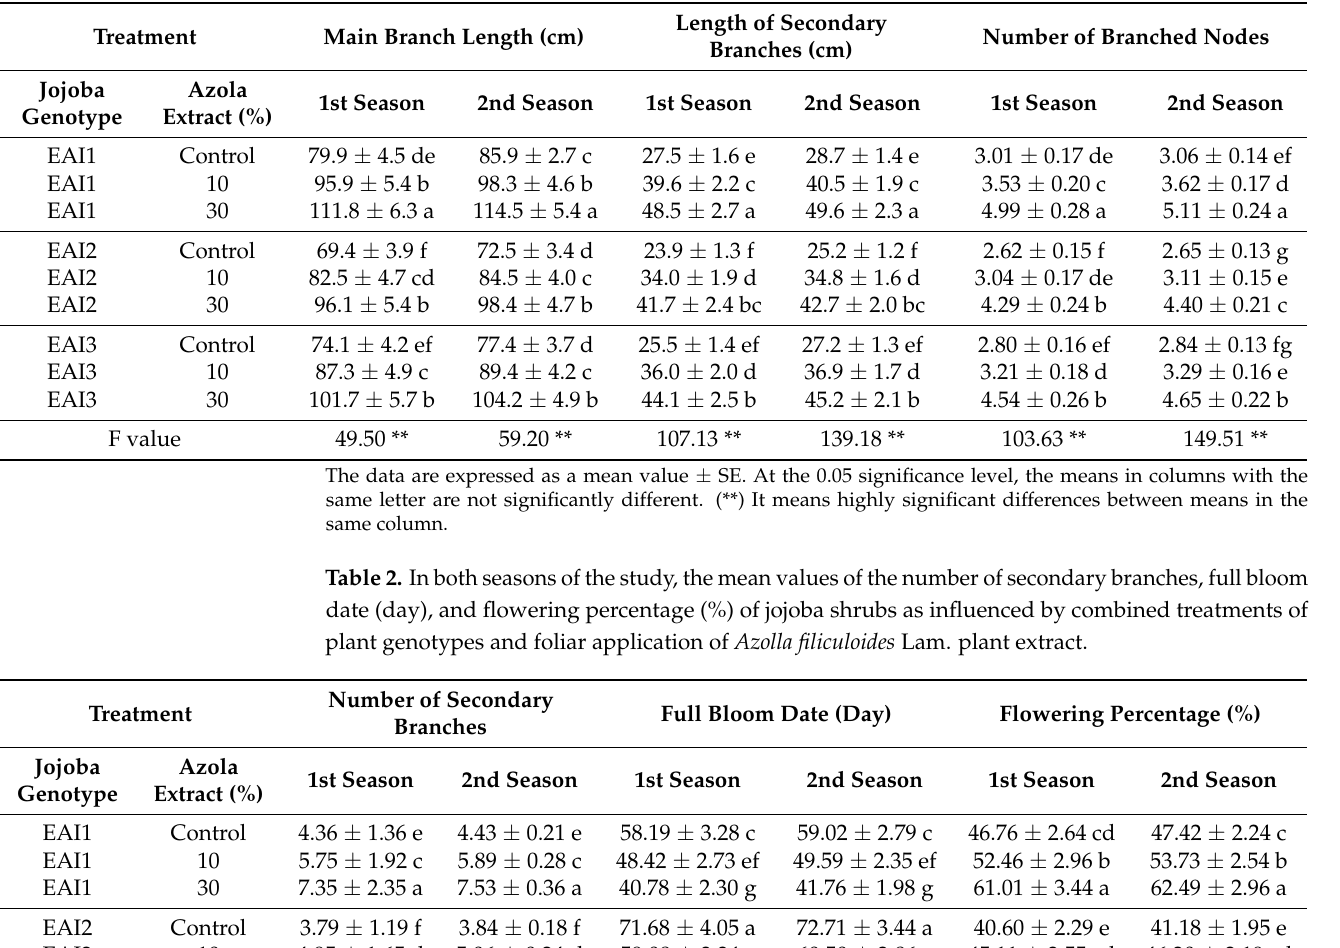
Table 1. In both seasons of the study, the mean values of main branch length (cm), secondary branch length (cm), and the number of branched nodes of jojoba shrubs as influenced by combined treatments of plant genotypes and foliar application of Azolla filiculoides Lam. plant extract.